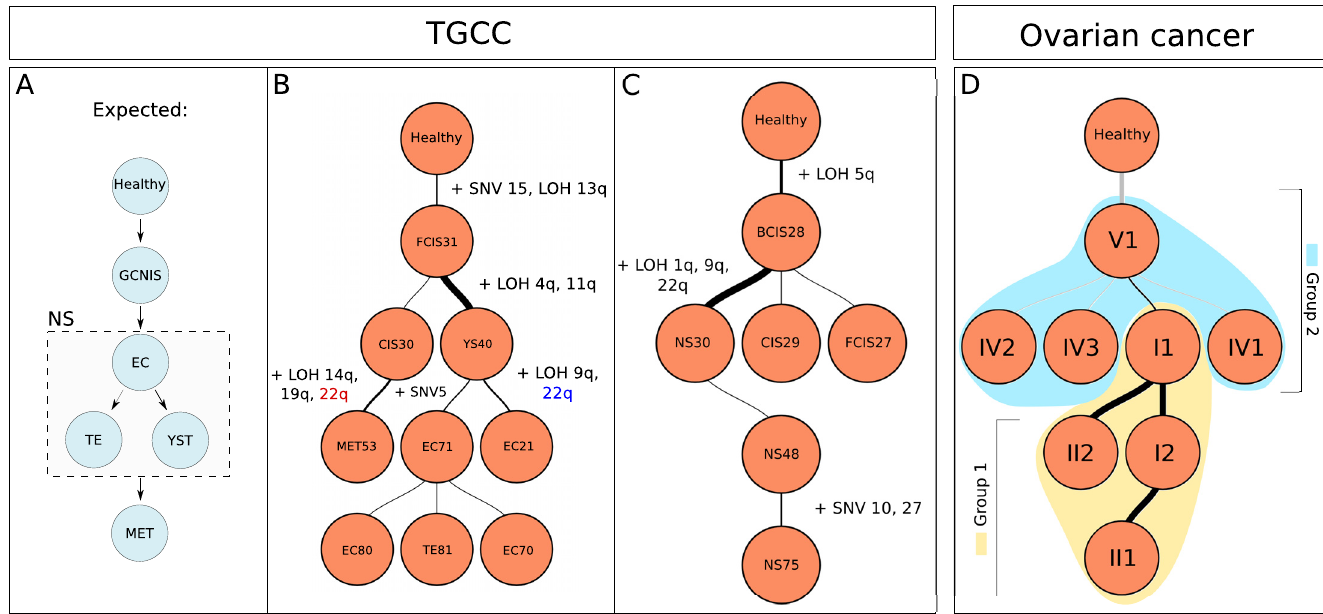
Fig 5. (A) Expected development of TGCC based on knowledge described in literature. (B) Tree reconstructed by TargetClone for T6107. (C) Tree reconstructed by TargetClone for T618. A few events have been annotated to show the relations between samples. In (B) , LOH at chromosome 22q is colored in blue and red to indicate that a different parental allele has been lost. A thicker line indicates that a larger number of events is introduced in the subclone. (D) Tree reconstructed by TargetClone for P1 of the ovarian cancer dataset. The two sample groups are placed in two clusters, as highlighted in yellow and blue. A description of how the trees are visualized can be found in S1